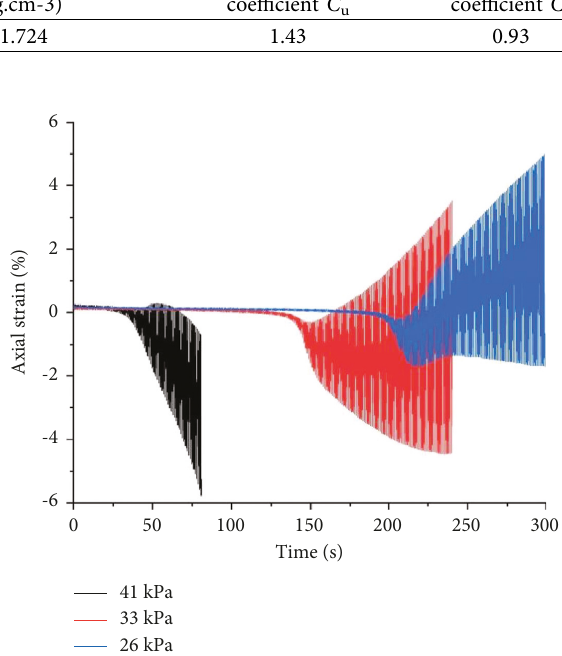
Figure 4: Comparison curve of the axial dynamic strain time history of standard